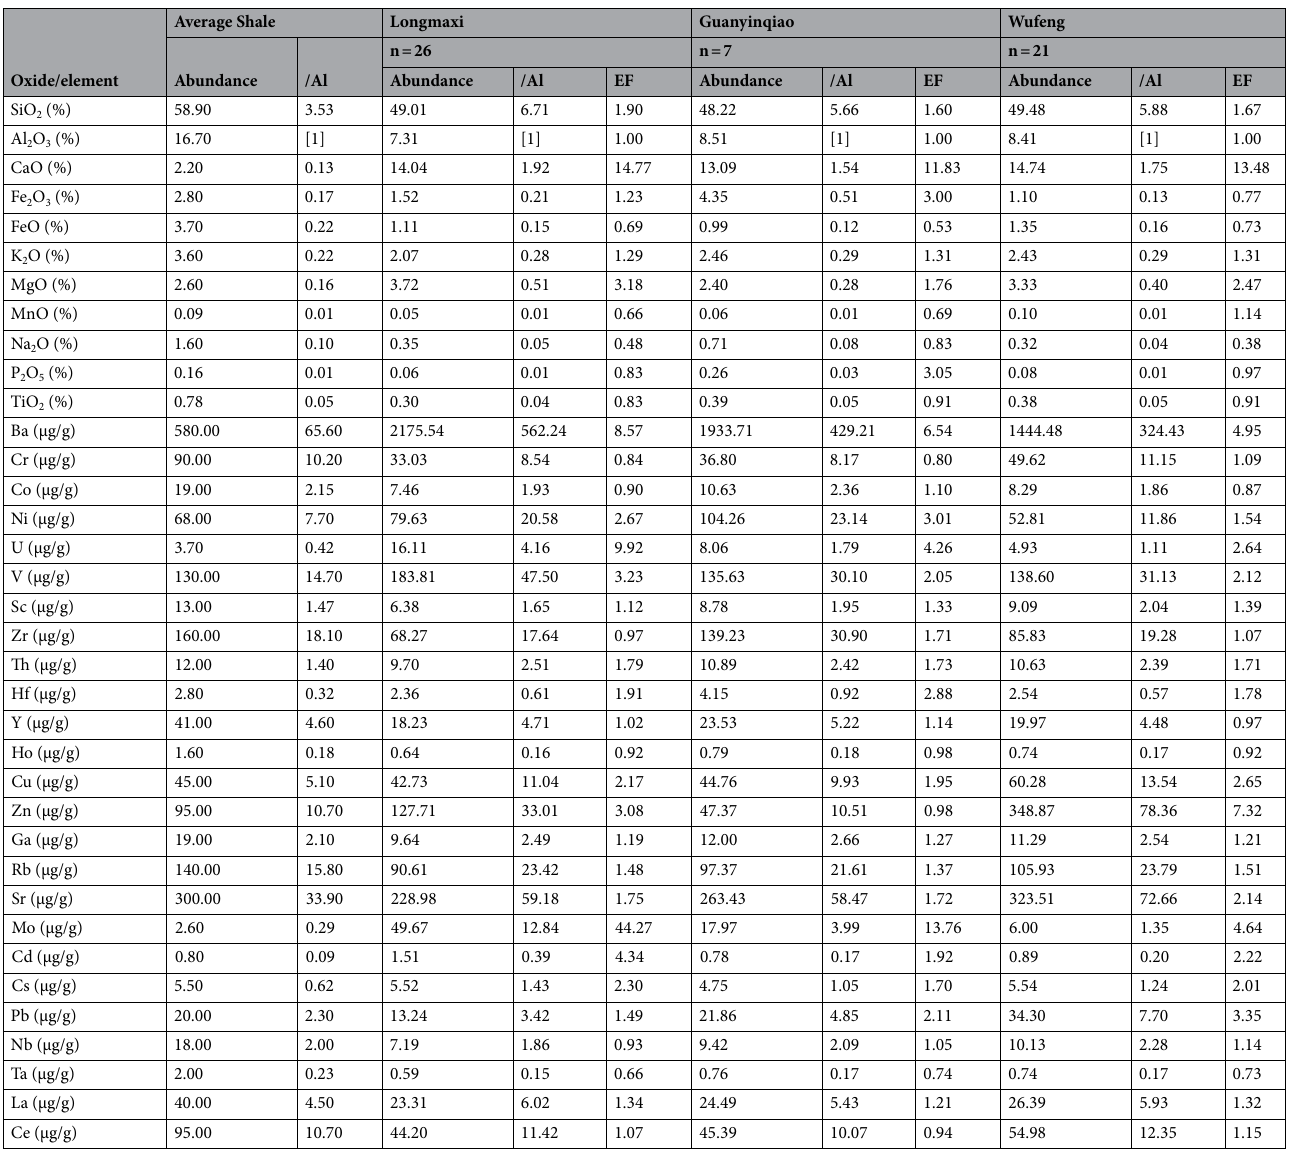
Table 5. Average concentrations of all elements normalized to Al from the Wufeng-Longmaxi formations in the Xindi No. 2 well.